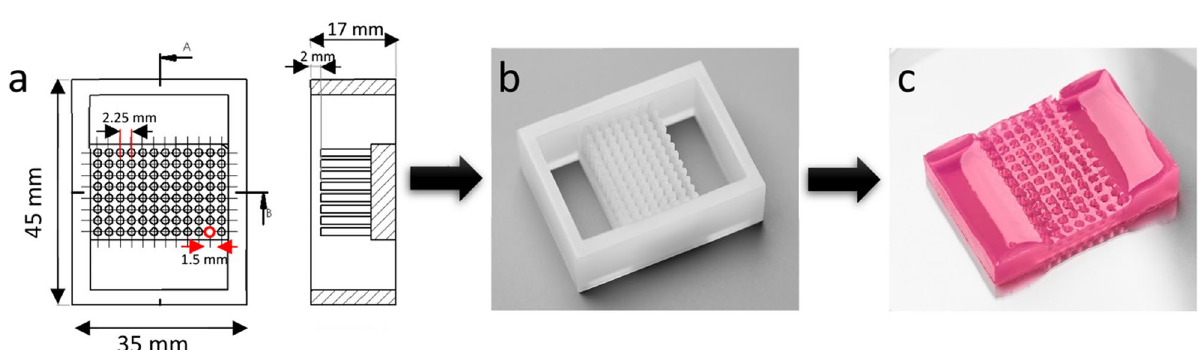
Figure 3. Histobrick design and hydrogel block. ( a ) CAD of the mould for the preparation of a 96-well HistoBrick, ( b ) Silicone mould fabricated by 3D printing, ( c ) Hydrogel-based HistoBrick containing 96